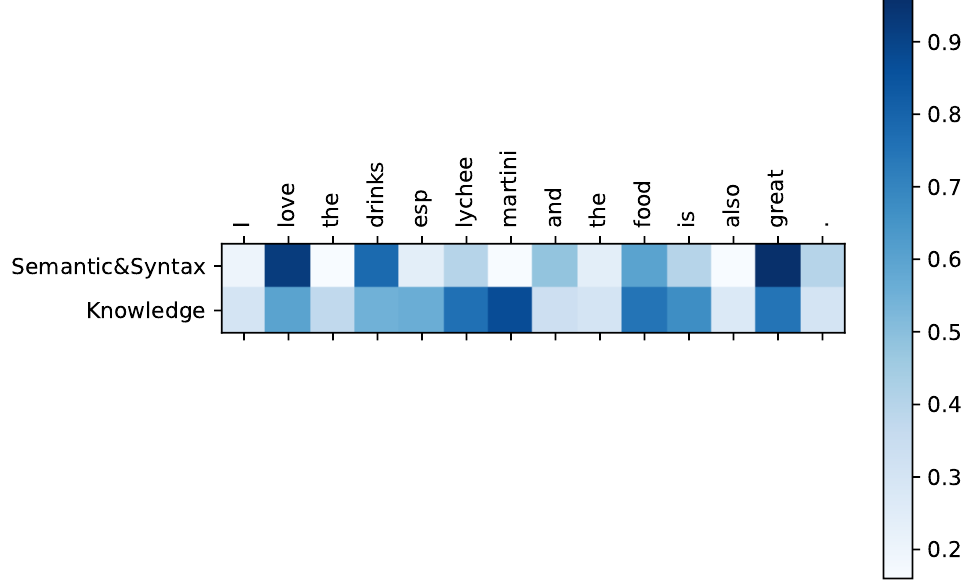
Figure 3. Attention weights to aspects ‘drinks’, ‘lychee martini’ and